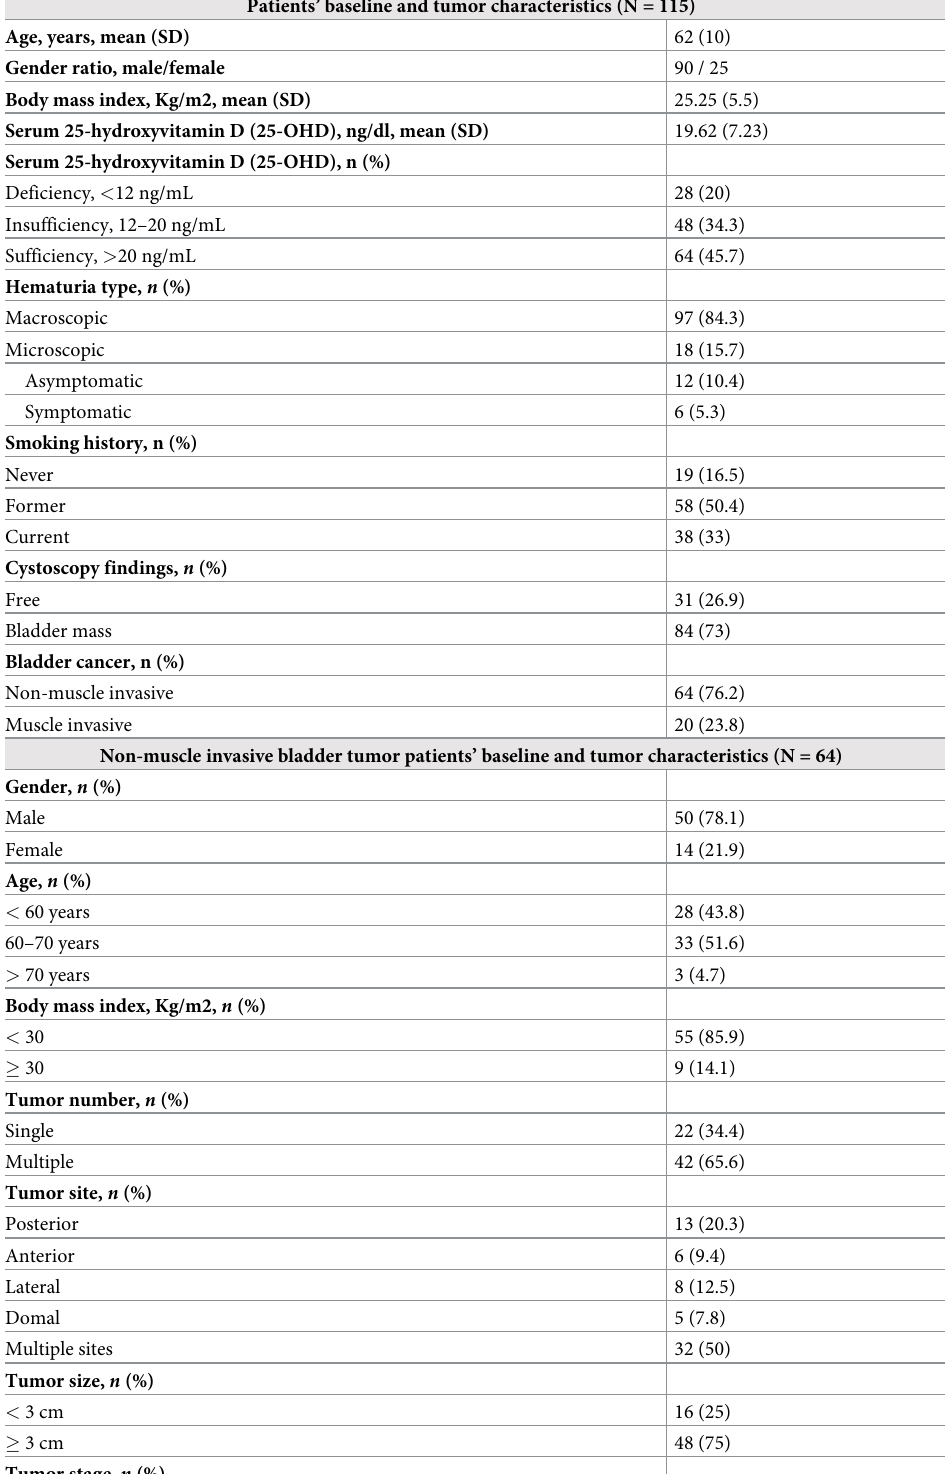
Table 1. Baseline patients and tumors